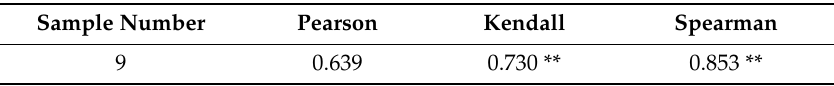
Table 7. Correlation analysis